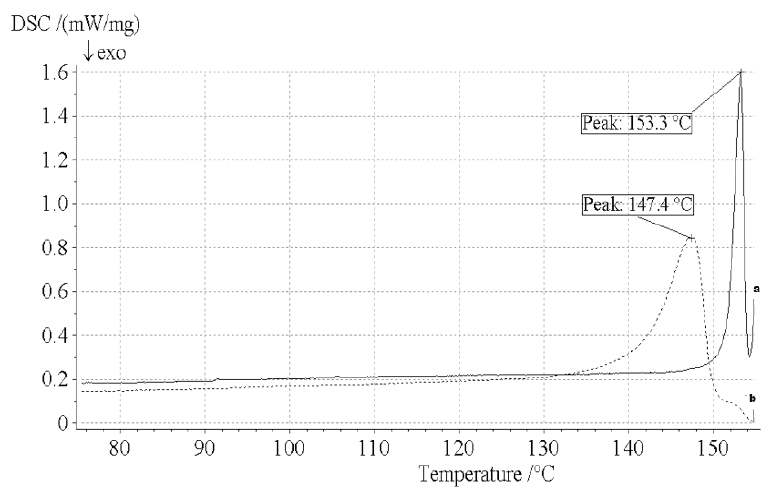
Figure 6. DSC analysis of before and after RESS processing. ( a ) Unprocessed artemisinin; ( b ) processed artemisinin.